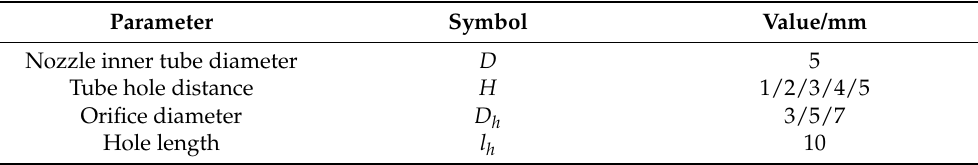
Table 1. Structural parameters of the experimental flow focusing/blurring nozzle.